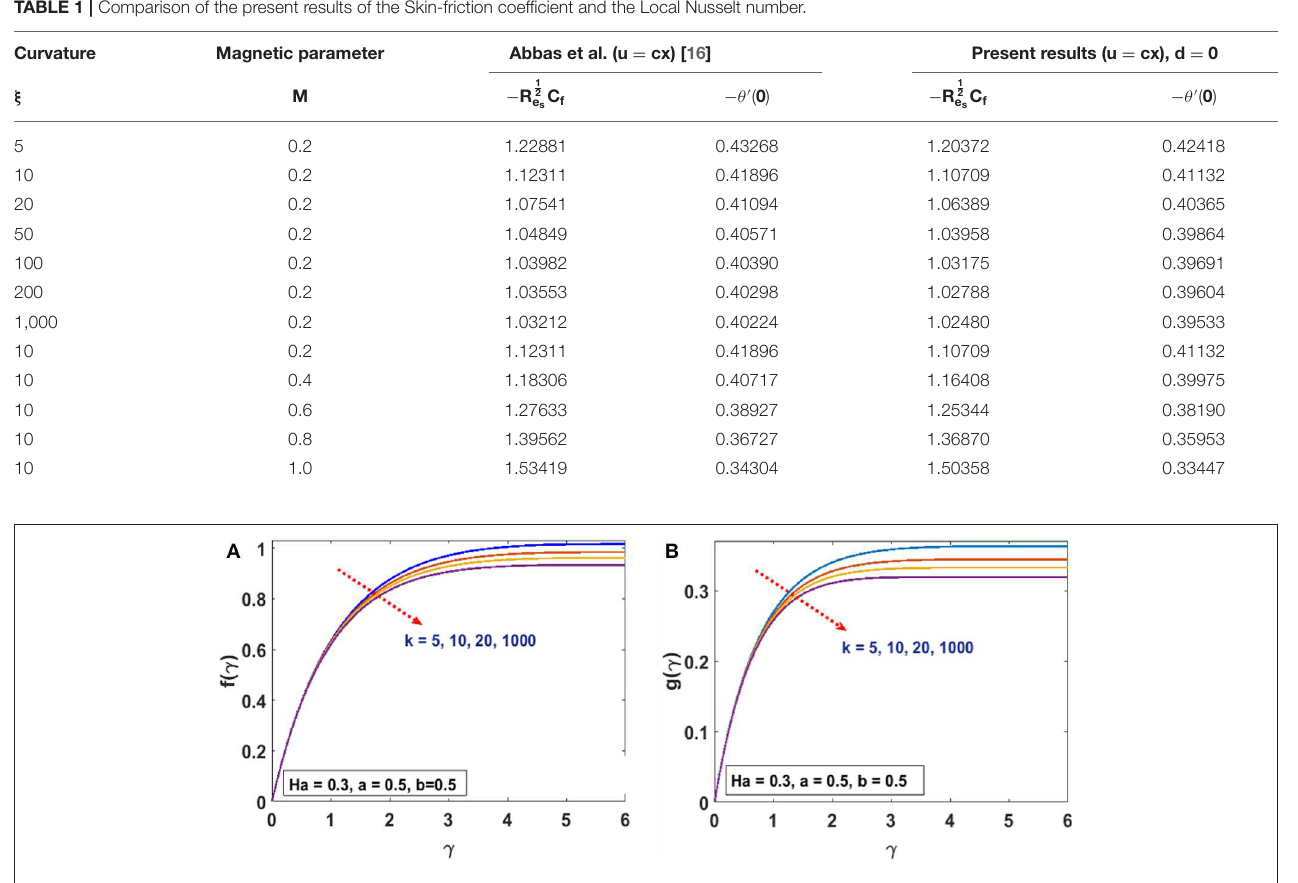
FIGURE 2 | (A) Effects of k on stream function f ( γ ). (B) Effects of k on stream function g ( γ